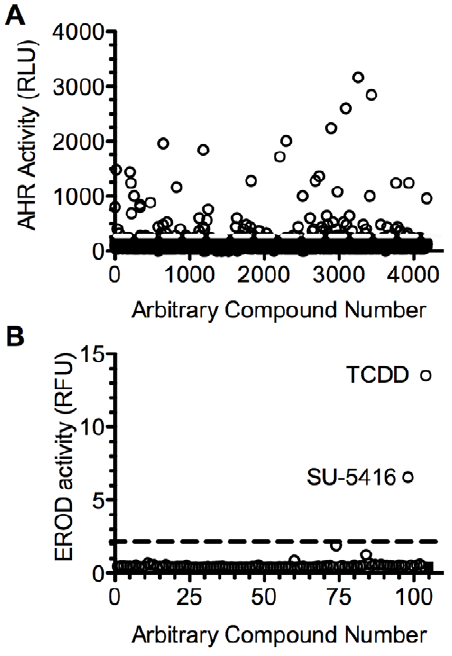
Figure 1. Screen of small molecule library for AHR agonists. A. A collection of 4160 compounds was screened for the induction of the DRE-driven luciferase in the human hepatoma 101L cell line. In 384-well plates, 100 m L media containing 70% confluent 101L cells was incubated with 10 m M of each test compound (1% v/v DMSO) for 24 hours. Dotted line indicates 3-fold induction. B. Screen for agonists of the AHR d . The AHRd-15 cell line was treated with 1 m M of the 98 compounds identified from the primary screen, 2 nM TCDD or DMSO and EROD activity was determined. Dashed line indicates 5-fold